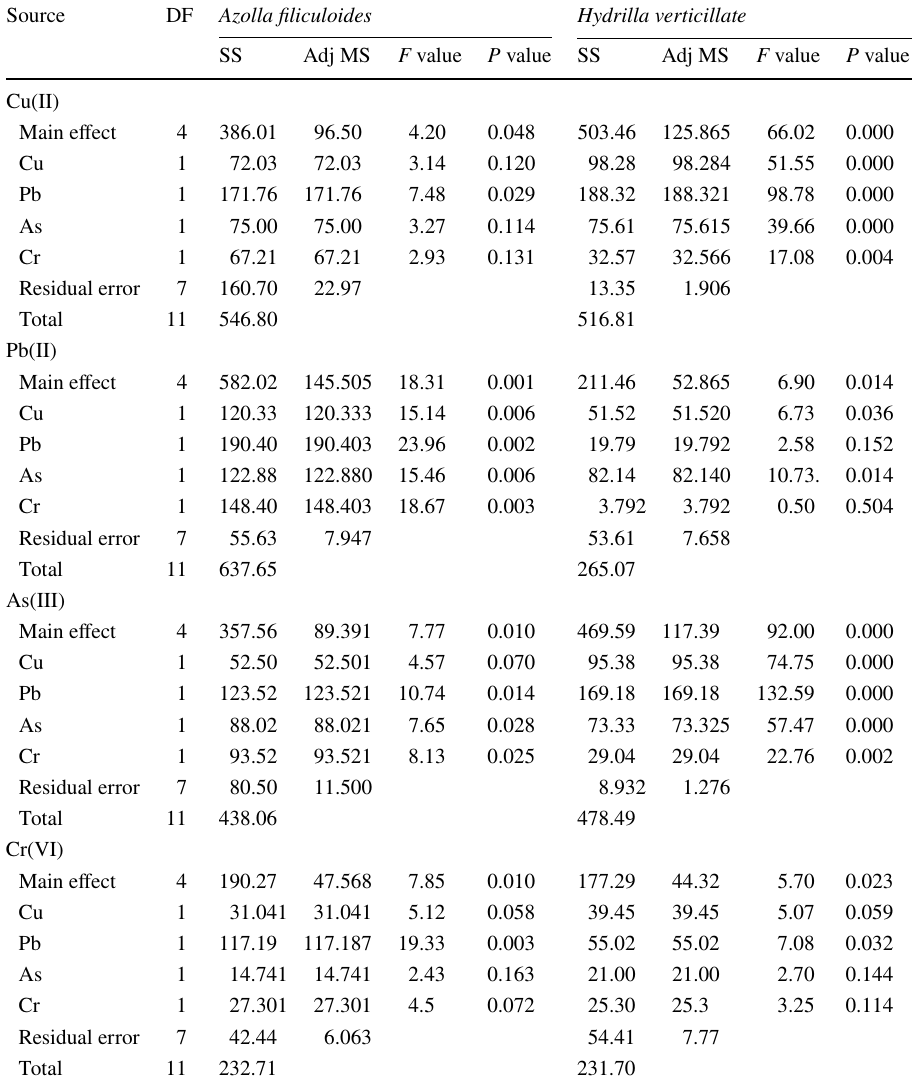
Table 2 Analysis of variance of heavy-metal removal from a multi-component system by Azolla filiculoides and Hydrilla